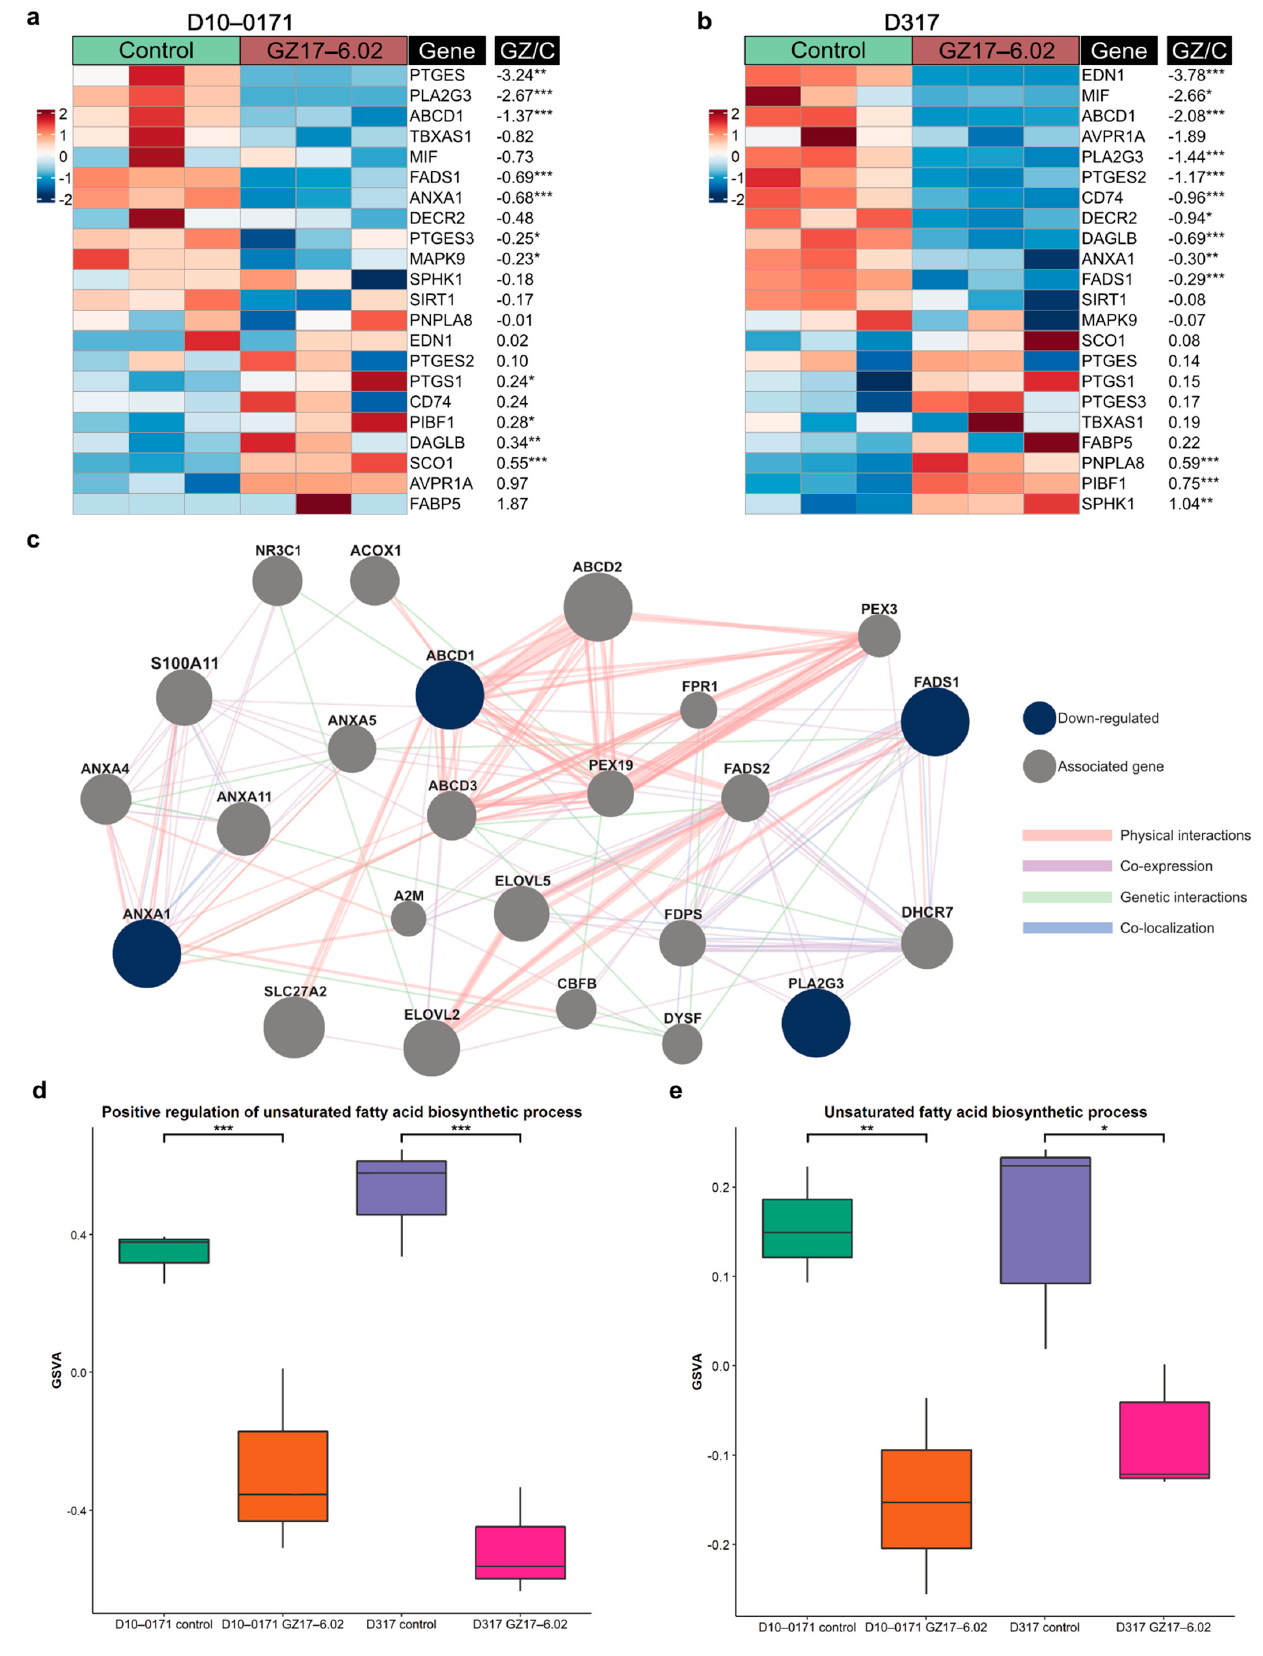
Figure 6. GZ17-6.02 downregulates unsaturated fatty acid biosynthesis. ( a ) Heatmap of mRNA expression of select unsaturated fatty acid biosynthesis related genes in control and GZ17-6.02